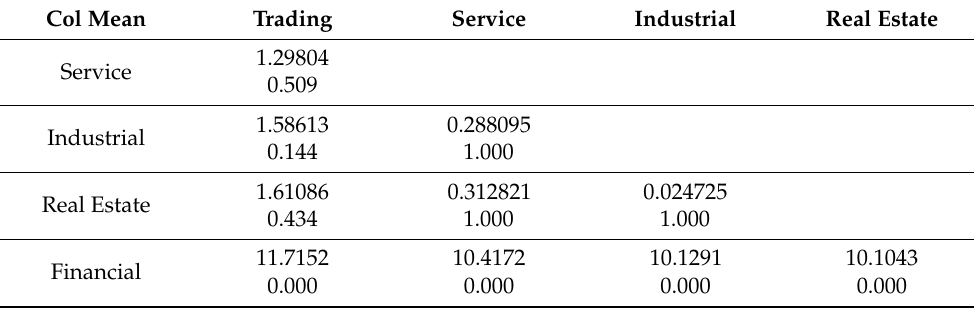
Table 6. Comparison of all FI disclosures by industries (Bonferroni) row mean.